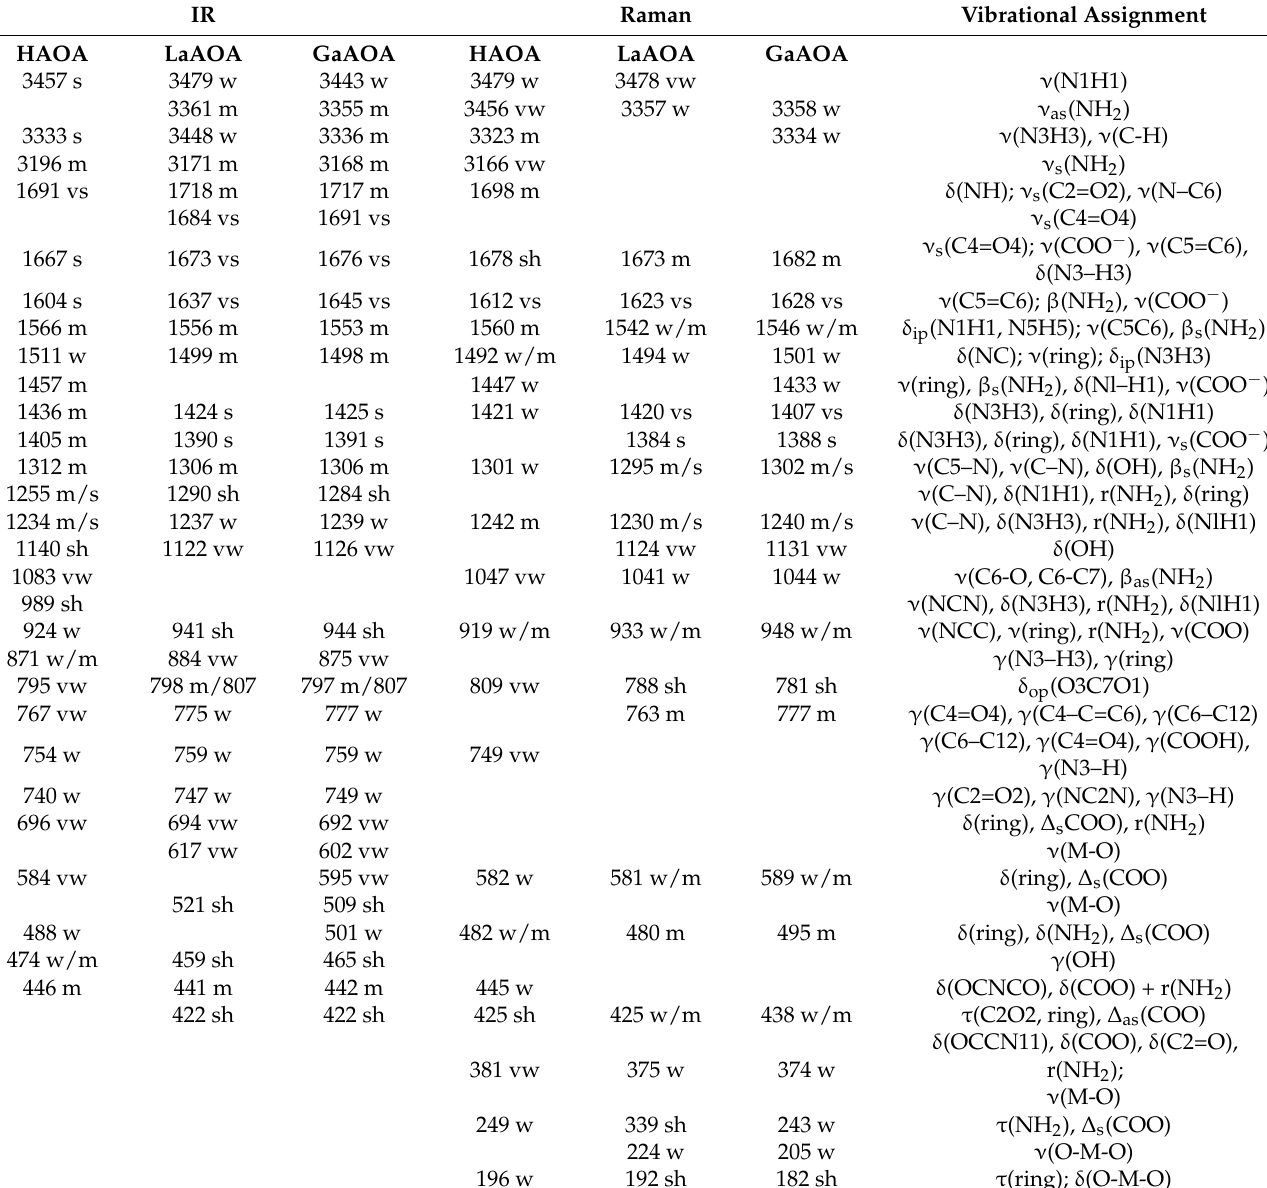
Table 1. Selected experimental IR and Raman wavenumbers (cm − 1 ) of 5-aminoorotic acid (HAOA) and its La(III) and Ga(III) complexes [LaAOA, GaAOA] and their tentative assignment. Abbreviations: vw—very weak; w—weak; m—medium; ms—medium strong; s—strong; vs—very strong; sh—shoulder; ν —stretching; δ —bending; τ —torsion; s—symmetric; as— asymmetric; def.—deformation; ip—in plane; op—out of plane; ring—pyrimidine ring; sciss—scissoring; wagg—wagging;